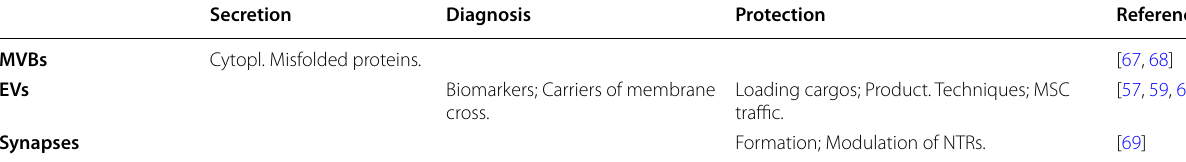
Exosomes play many critical roles in neurodegenerative diseases. Among such roles I have chosen three reported in the present Table. Misfolded proteins of cytoplasmic nature, relavant for unconventional Secretion, are loaded into exosome cargos during vesicle assembly at the MVB surface. EVs of exosomes, released upon MVB exocytoses, predominate in various types of functions: in terms of Diagnosis, by biomarkers and carriers across membrane barriers; and in terms of Protection, by loading of cargos, production of techniques, and MSC circulation. Contribution of exosomes to the formation of Synapses and modulation of their NeuroTransmitter Release are relevant in terms of